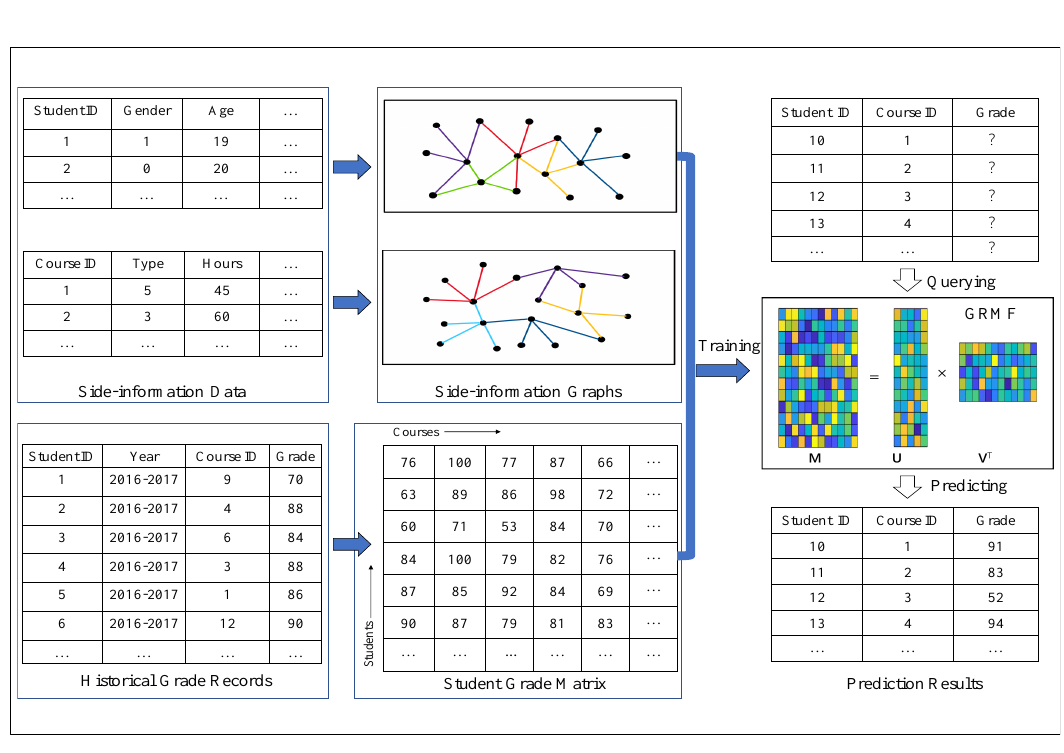
Figure 1. The proposed workflow of student grade prediction using